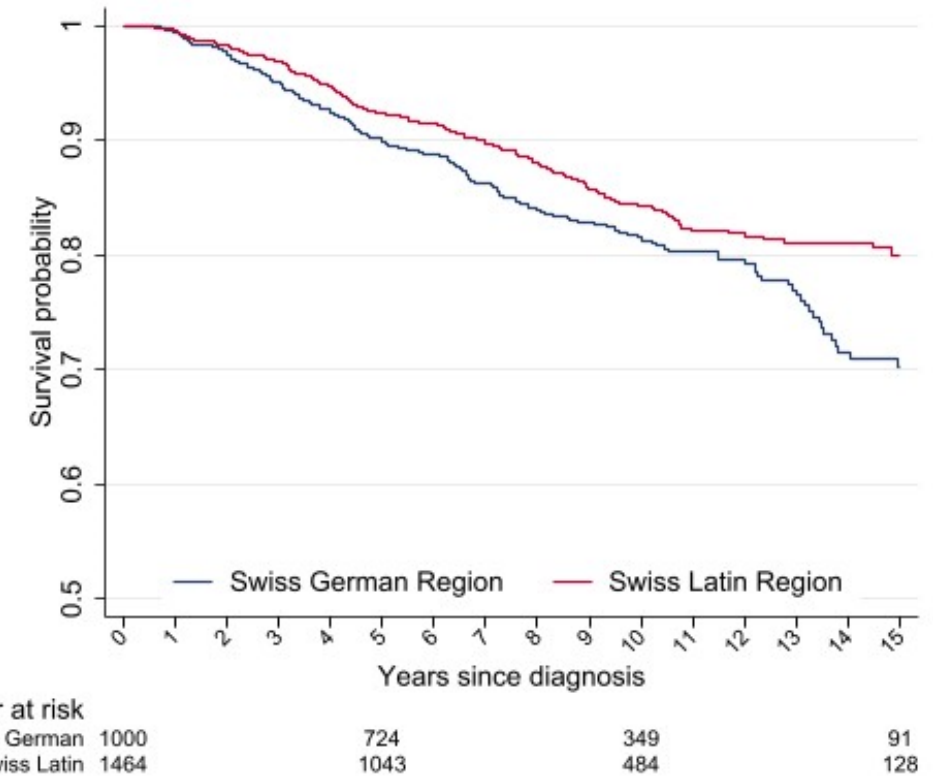
Figure 2. Kaplan–Meier estimates for overall survival of young women with breast cancer treated between 2000 and 2014 in Switzerland. Table 4. Univariate and multivariable associations between clinicopathological factors and overall survival.